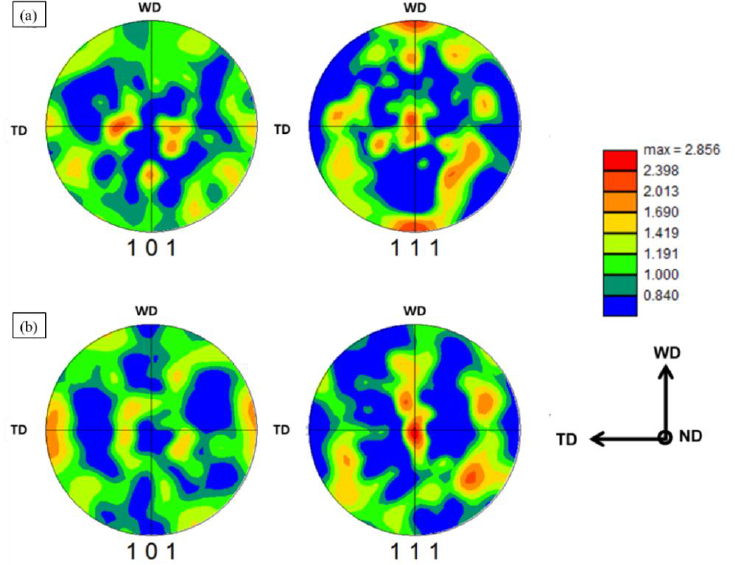
Figure 15. 101 and 111 PFs calculated from the data from SZ of T-butt Friction stir welded joint presented in Figure 13, where ( a ) AA2024-T4 and ( b ) AA7075-T6.